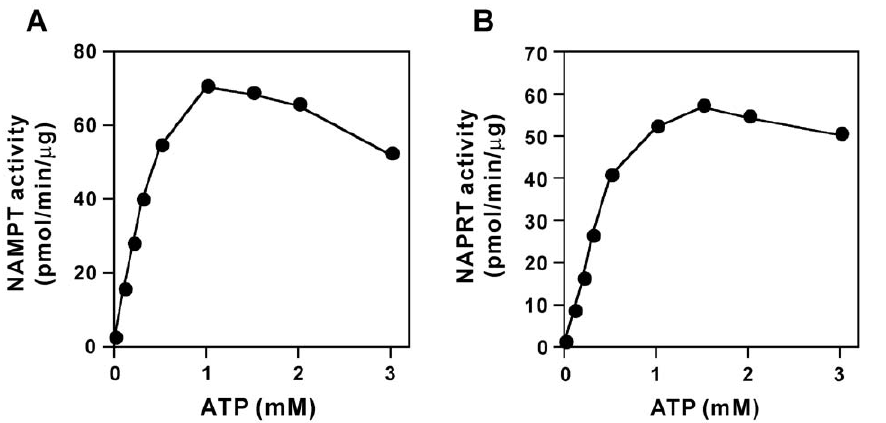
Figure 2. ATP is an essential activator of NAMPT and NAPRT reactions. NAMPT (A, 15 ng) and NAPRT (B, 20 ng) were incubated with 20 m M [ 14 C]Nam and [ 14 C]NA for 6 and 7 min, respectively, in the presence of 1 m M PRPP and indicated concentrations of ATP. The amounts of NMN (A) and NaMN (B) formed were determined. Data in figures 2 and 3 are representative of at least three experiments.